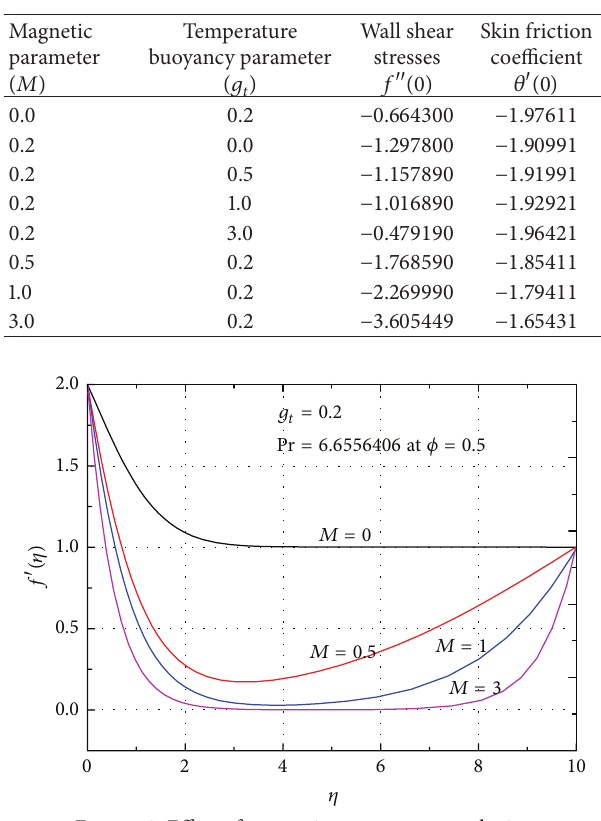
Table 1: Nanofluid properties. Table 2: Values of 𝑓 󸀠󸀠 (0) and 𝜃 󸀠 (0) for Pr = 6.6556406 and 0 = 0.05 obtained by shooting method.